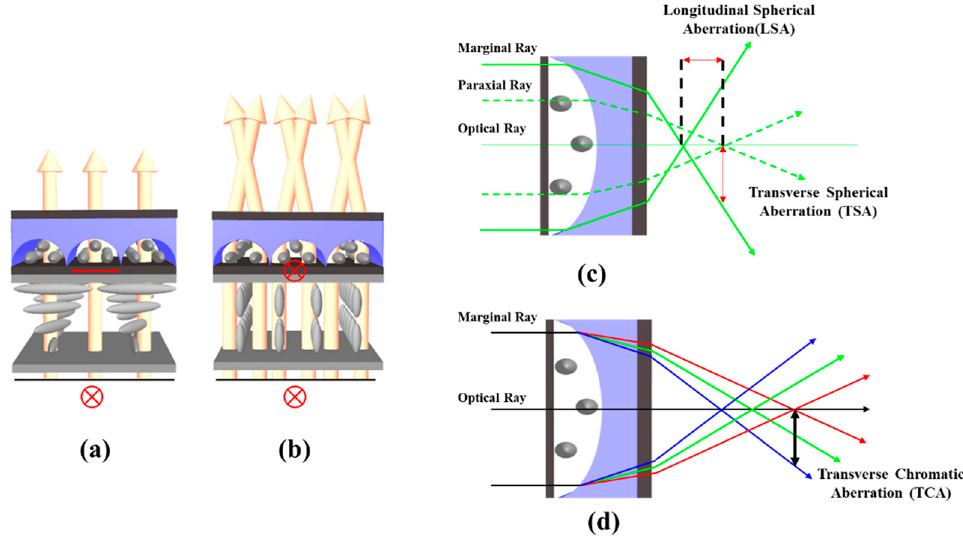
Figure 1. Structure and operating principle of the polarization-dependent-switching liquid crystal (LC)-based gradient refractive index (GRIN) lens array operated through the underlying polarization-switching layer: ( a ) field-off state and ( b ) field-on state of the polarization switching twisted nematic LC layer. ( c ) Aberrations induced by additional refraction between the air and the flat substrate interface. ( d ) Transverse chromatic aberration induced by the material dispersion.